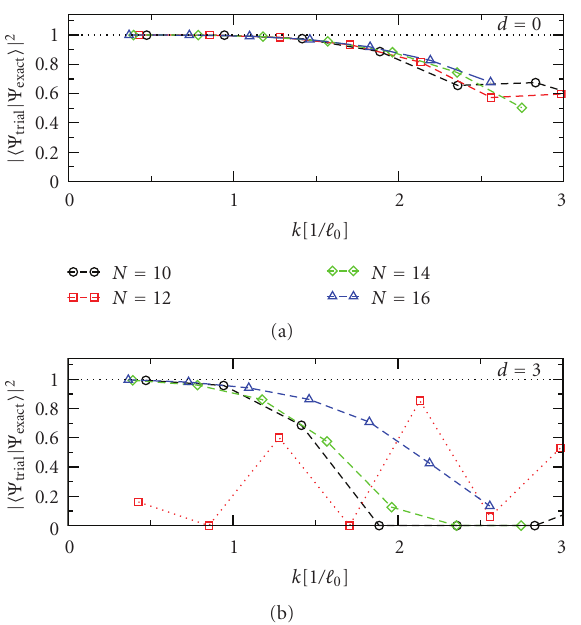
Figure 2: Overlaps of the trial states for the Goldstone mode at d = 0 (a) and d = 3 (b) with the exact state, as in Figure 1, plotted (cid:10) here as a function of wavevector k ∼ L/ N φ / 2. Despite the size of the Hilbert spaces increasing significantly between the smallest and largest system shown, the overlap remains roughly constant or maybe slightly increases with N . The region of high overlap extends roughly up to k ≈ 2 (cid:3) − 1 0 . The failure of this approach for d = 3 and N = 12 is discussed in detail in the text.